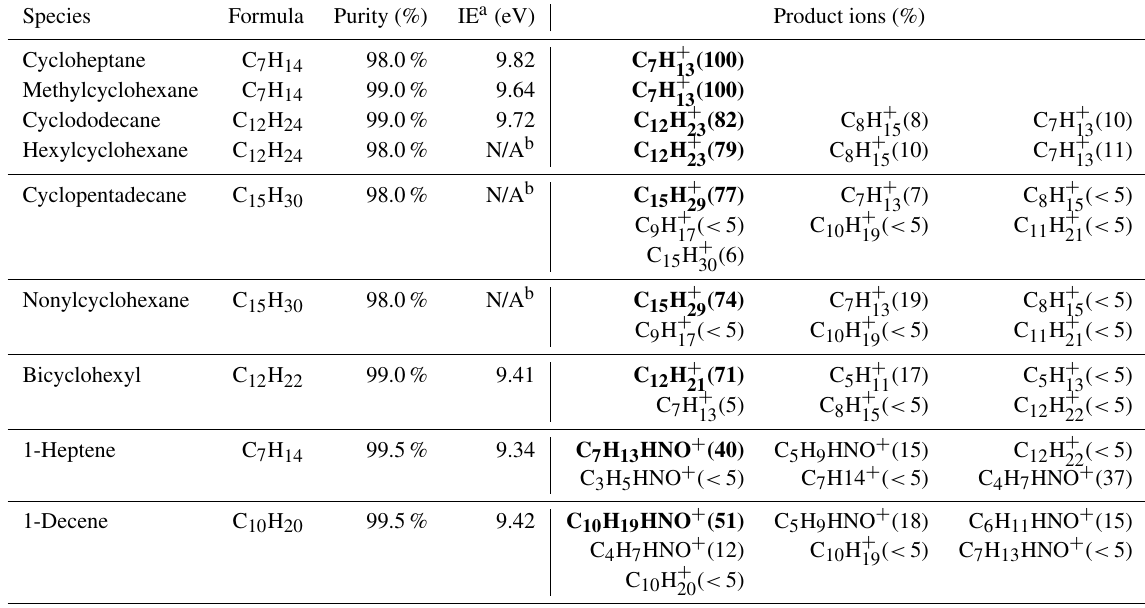
Table 1. The formula, purity, and ionization energy (IE) of the species used in product ion characterization experiments are shown. The percentage of each product ion from the reactions with NO + ions is indicated in parentheses, and the major product ions are identified in